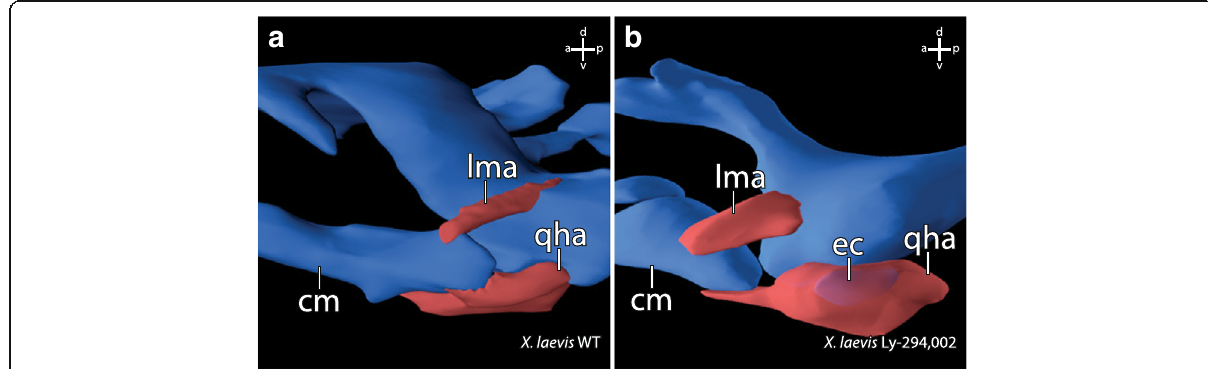
Fig. 4 3D-reconstructions based on confocal laser scanning microscopy of specimen stained with antibodies showing the effects of bapx1 upregulation on cranial muscle morphology in Xenopus laevis larvae. Lateral view of the jaw articulation and selected muscles of ZO 17 larvae. a Muscle morphology in a control specimen. b Muscle morphology in a specimen after bapx1 upregulation. The m. levator mandibulae articularis originates more anteriorly on the dorsal surface of the processus muscularis than in control specimens. The m. quadratohyoangularis surrounds the ectopic cartilage without originating from or inserting onto this cartilage. cm, Meckel ’ s cartilage; ec, ectopic cartilage; lma, M. levator mandibulae articularis; qha, M. quadratohyoangularis